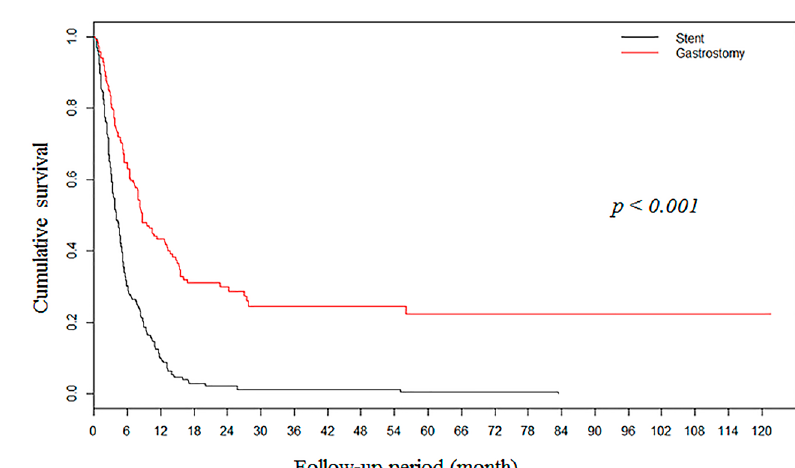
Figure 2. Kaplan–Meier survival curves showing overall survival rates of 383 patients with malignant esophageal obstruction after gastrostomy ( n = 188) and stent insertion ( n = 195).